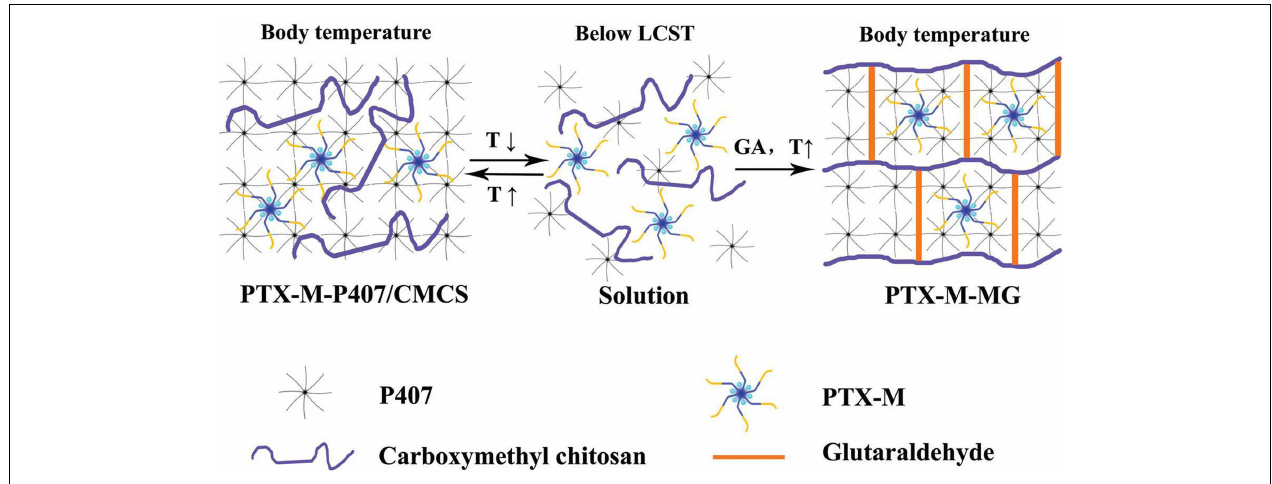
FIGURE 1 | Loaded polymeric micelles (PTX-M) are dispersed in a physical hydrogel formed by triblock copolymer (P407) at elevated temperature .The hydrogel is then reinforced by chemical crosslinks of carboxymethyl chitosan with glutaraldehyde. Reprinted from Ju et al. (2013) with permission.